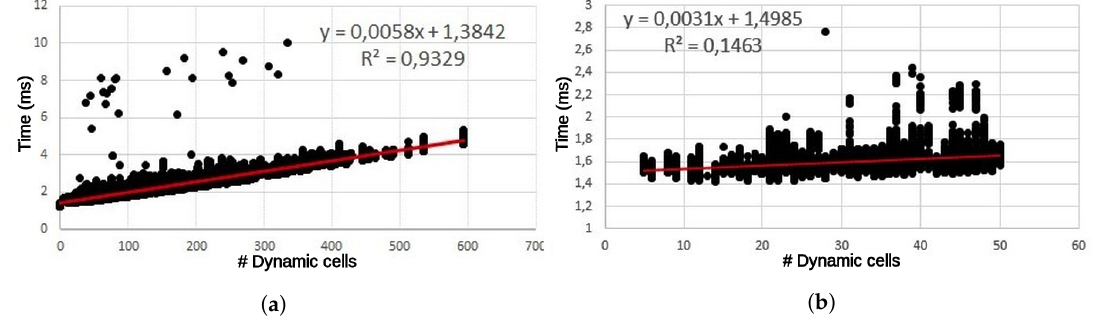
Figure 13. Latencies of GPGPU version vs. number of dynamic cells. ( a ) For all number of dynamic cells of the dataset; ( b ) Zoom from 1 to 50 dynamic cells.